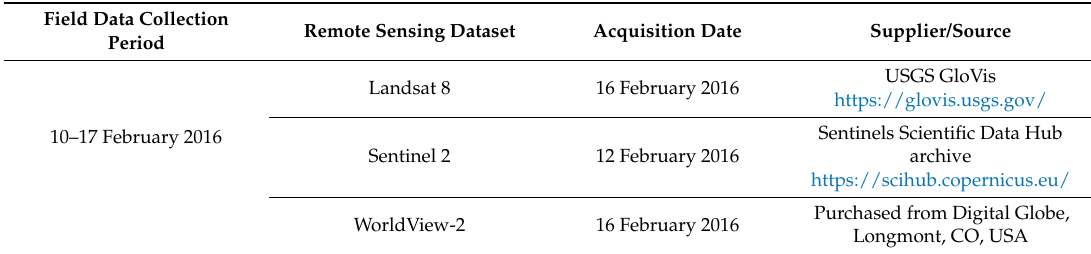
Table 1. Summary of datasets acquired and used in this